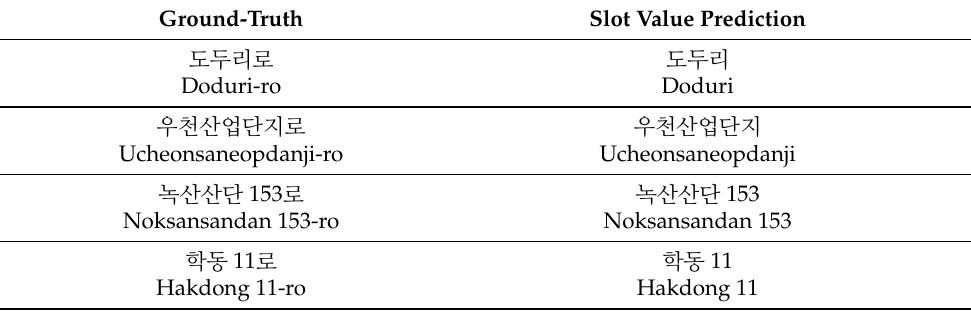
Table 7. Examples for missing address name units error.